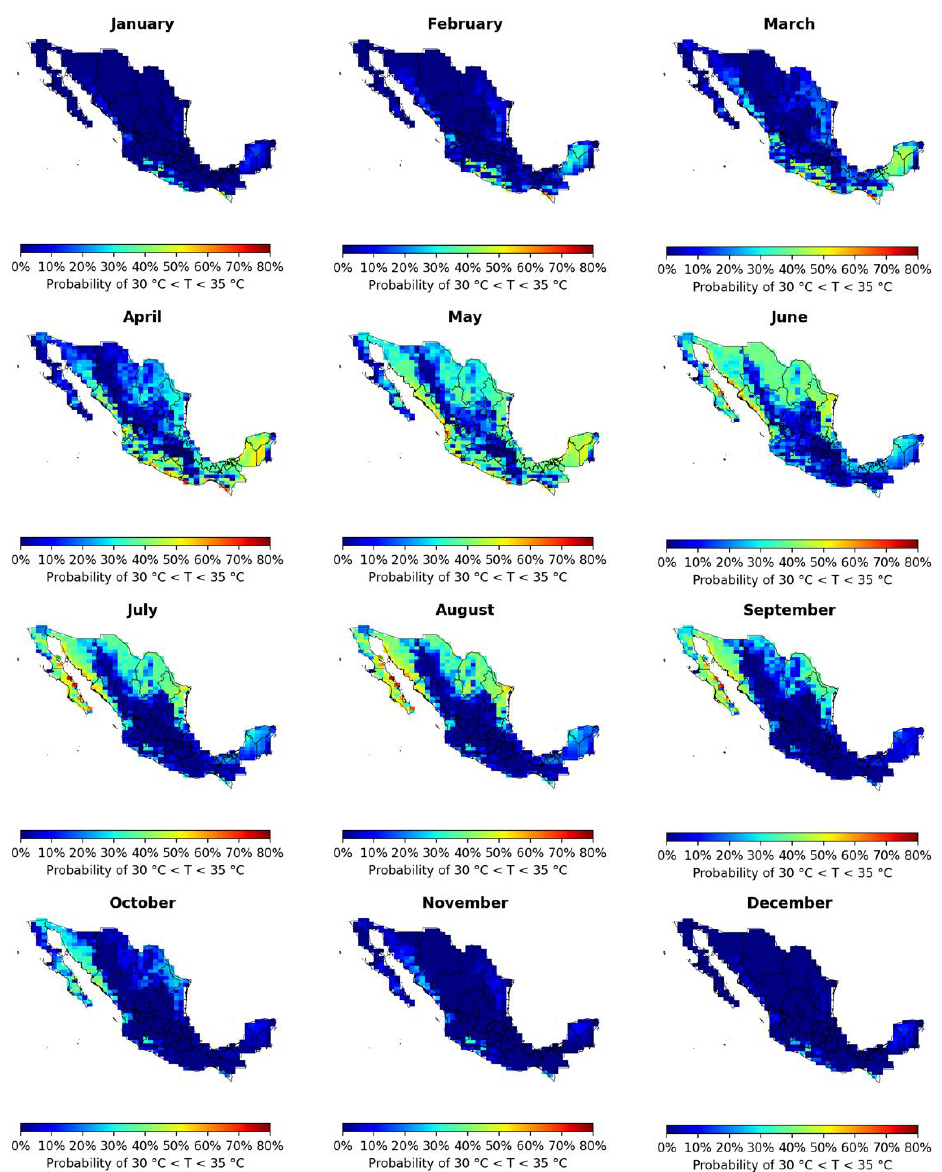
Figure 7. Probability map of ambient temperatures between 30 ◦ C and 35 ◦ C per month in Mexico. This information is enough to compute the mean daily PV energy for a given PV module, which is performed in the following subsection.